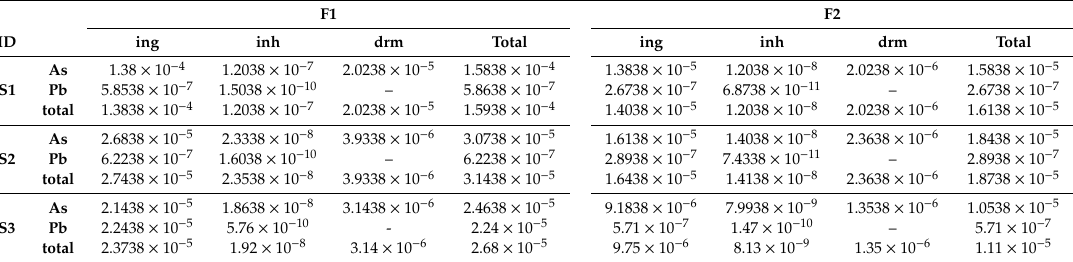
Table 2. Estimated human health risk for elements As and Pb.